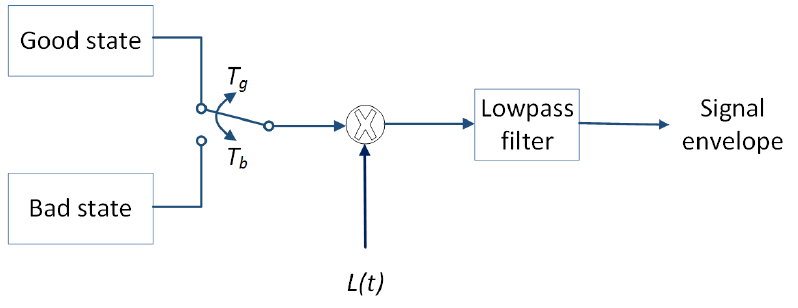
Figure 8. Channel simulator for BBWNs during running and cycling. L ( t ) is the component of the large scale fading, T g and T b are the period of good and bad states,